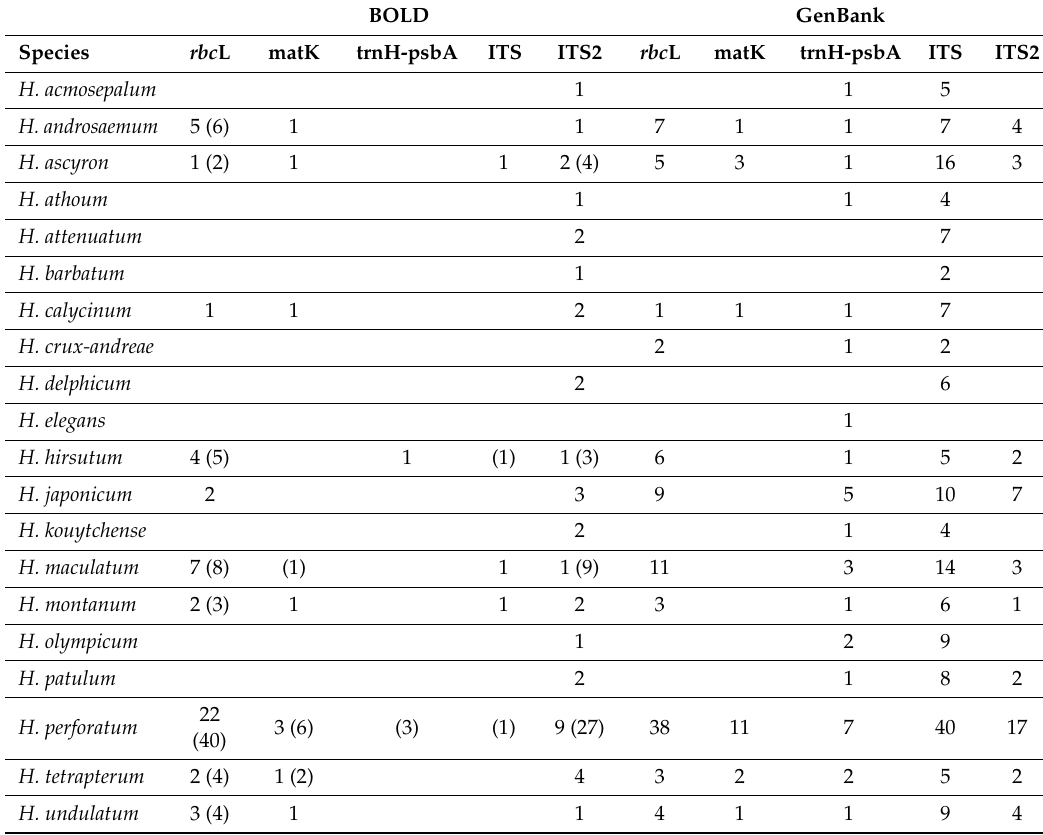
Table 1. Availability of Hypericum panel barcode sequences in Barcode of Life Database (BOLD) and GenBank. Figures reported for BOLD represent the number of full accessions, with the total number, including those mined from GenBank, shown in parentheses. (Figures from March 2020). BOLD GenBank Species rbc L matK trnH-psbA